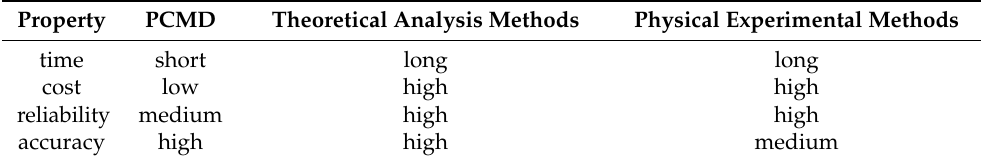
Table 3. Comparison between different